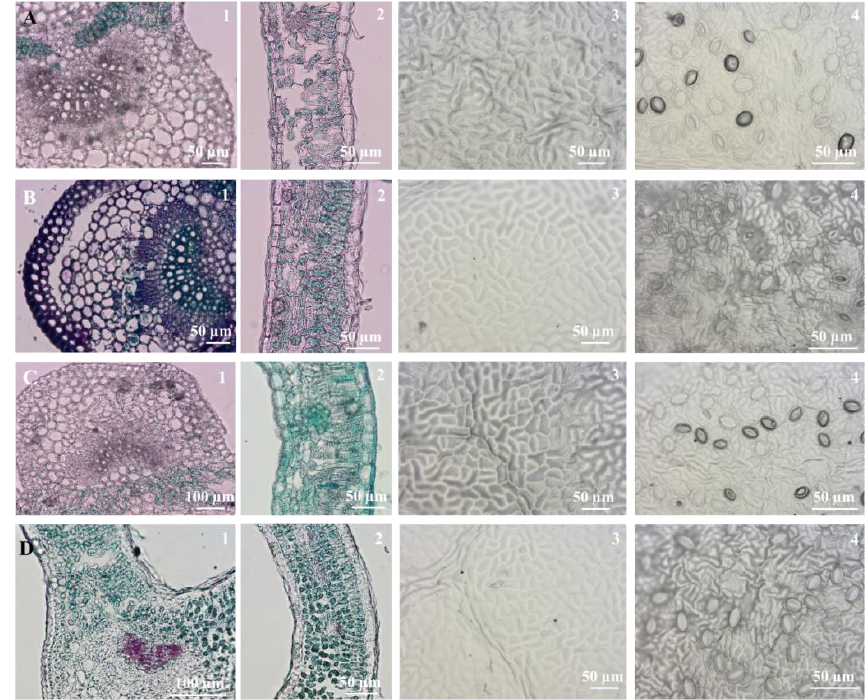
Figure 7. Cross sections of leaves in peach hybrids under in vivo acclimatization for 60 days: ( 1 ) central vein, ( 2 ) leaf and casts of their integumentary tissues ( 3 ) adaxial epidermis, ( 4 ) abaxial epidermis. ( A ) ‘Clyde Wilson’ × ‘Nikitskiy Podarok’, ( B ) ‘Jerseyglo’ × ‘Nikitskiy Podarok’, ( C ) ‘Loadel’ × ‘Nikitskiy Podarok’, ( D ) ‘Summerglo’ × ‘Nikitskiy Podarok’. Bars = 50 μm.